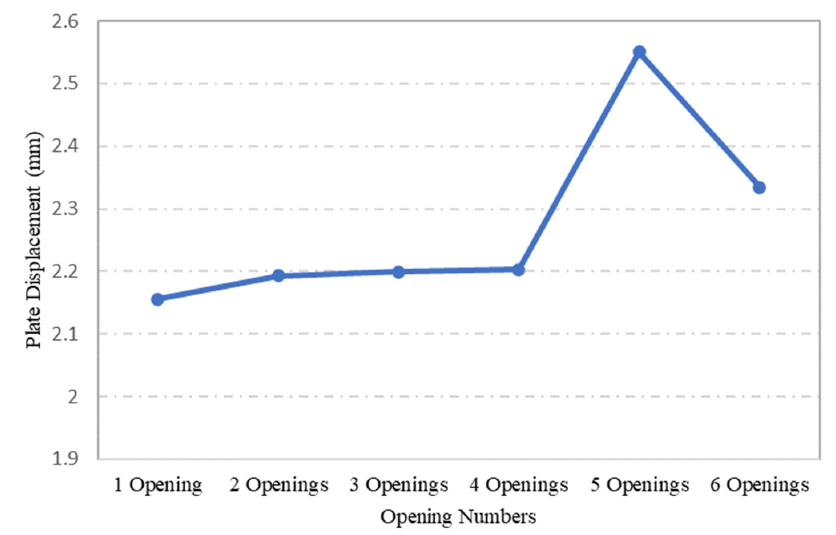
Figure 17. Influence of opening numbers on the maximum displacement of plates.